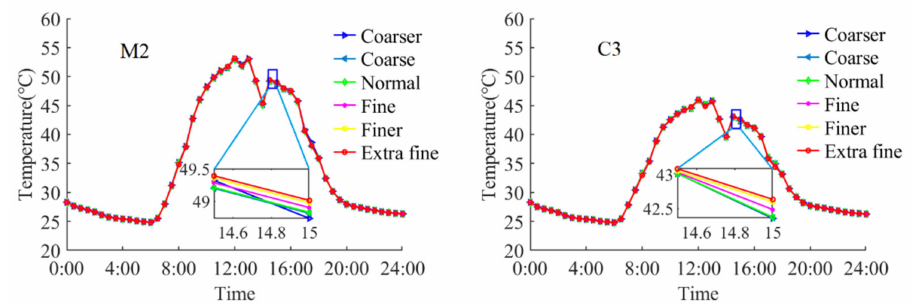
Figure 9. The temperature variation of M2 and C3 for different mesh